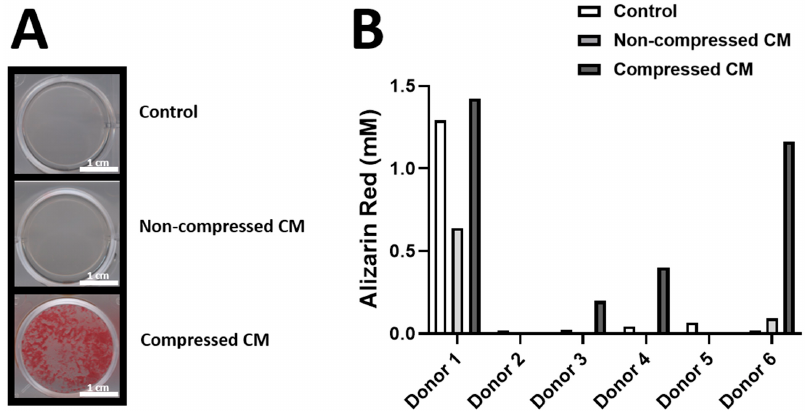
Figure 4. Figure 4. Effect of CM from (non-)compressed DU145 cells on O-hASC mineralization. ( A ) Rep- resentative Images of formed bone nodules (Alizarin Red staining) by O-hASCs (6 donors, n = 6) that were cultured in conditioned medium (CM) from DU145 cells that were either or not com- pressed with 2 kPa (mixed 1:2 with osteogenic medium) (scale bar = 1 cm). Control = O-hASCs, cultured in unconditioned PC medium (also mixed 1:2 with osteogenic medium). ( B ) Alizarin Red concentrations (mM) (calculated by plotting the Alizarin Red absorbance values at 590 nm using spectophotometry against the absorbance values of known Alizarin Red concentrations) corre- sponding to the formed bone nodules by O-hASCs from the 6 donors.